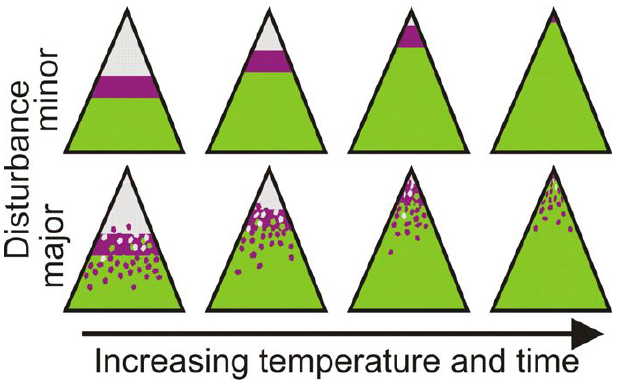
Fig. 3 . Schematic illustration of vegetation zones on a mountain determined by an elevation temperature gradient (green lower, darker purple mid, and grey upper) with minor (above) and major (below) disturbances. A greater frequency of disturbance increases the elevation range covered by the vegetation zones (in so far as dispersal allows). If disturbance was increased sufficiently, the three species would, one by one, be eliminated entirely (not